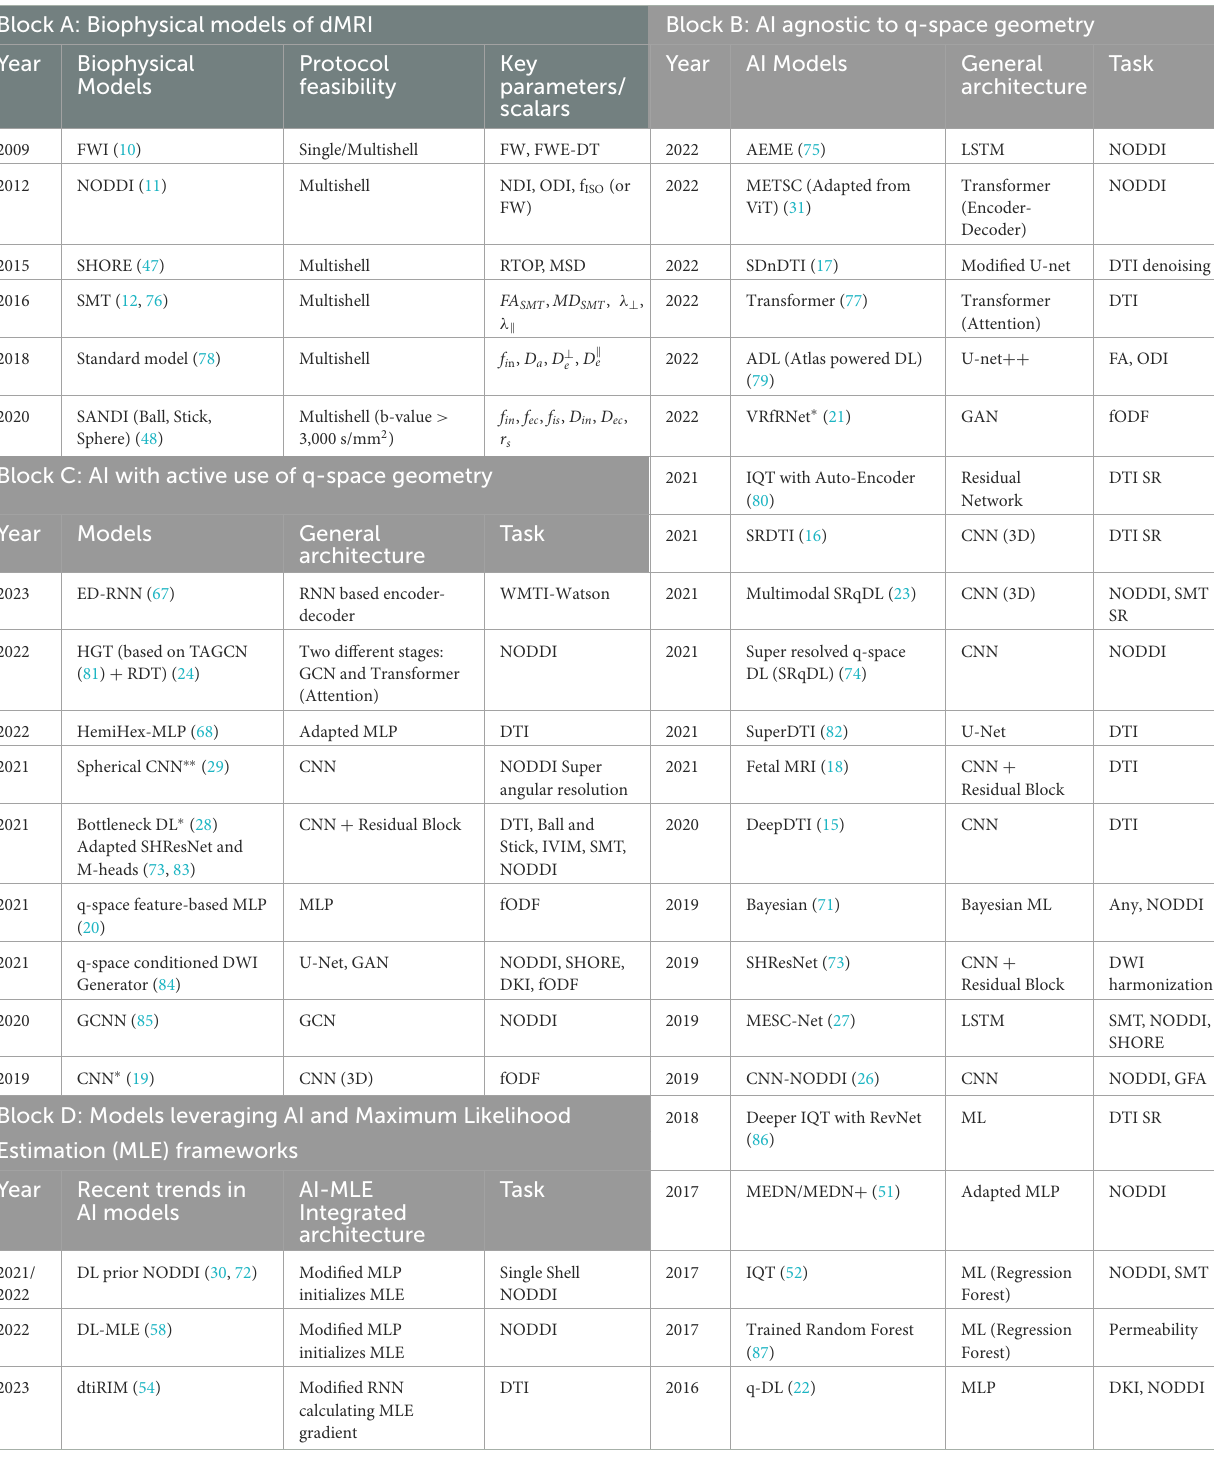
TABLE 1 Summary of biophysical models with their key parameters and studies conducted on diffusion MRI using AI in human brain. Block A: Biophysical models of dMRI